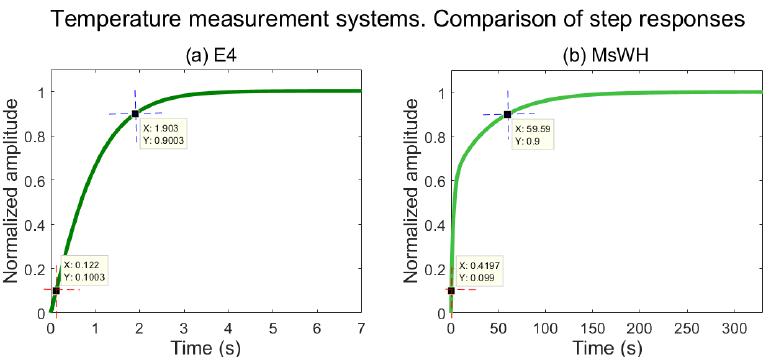
Figure 13. Step response of the body temperature measurement systems. ( a ) Empatica E4 wristband. ( b ) MsWH. SRT E 4 ≈ 1.9 s. SRT MsWH ≈ 59.59 s. Both subfigures have been obtained using the Matlab System Identification Toolbox.